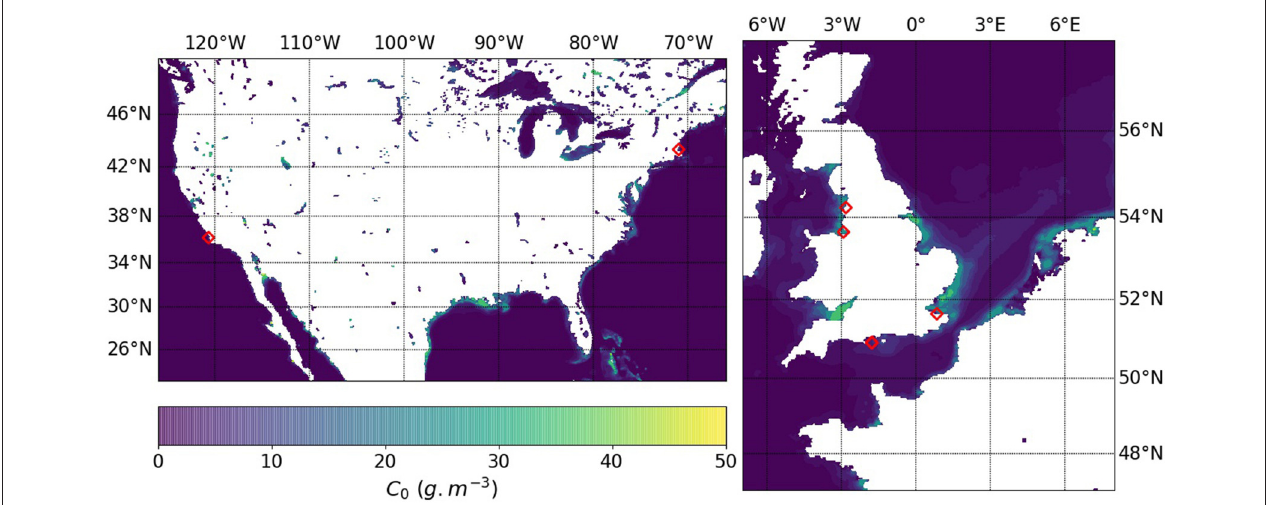
FIGURE 2 | Location of the selected tidal stations over a map of averaged monthly Total Suspended Matter concentration between 2002 and 2012. In the United States, the stations are Port San Luis for the Morro Bay marsh (California) and Boston for the Boston Harbor marsh (Massachusetts). In the United Kingdom, the stations are: Heysham for the Morecambe Bay marsh, Gladstone for the Mersey Estuary marsh, Bournemouth for the Poole Harbour Shell Bay, Wych Lake and Arne Bay marshes, and Sheerness for the Swale Estuary